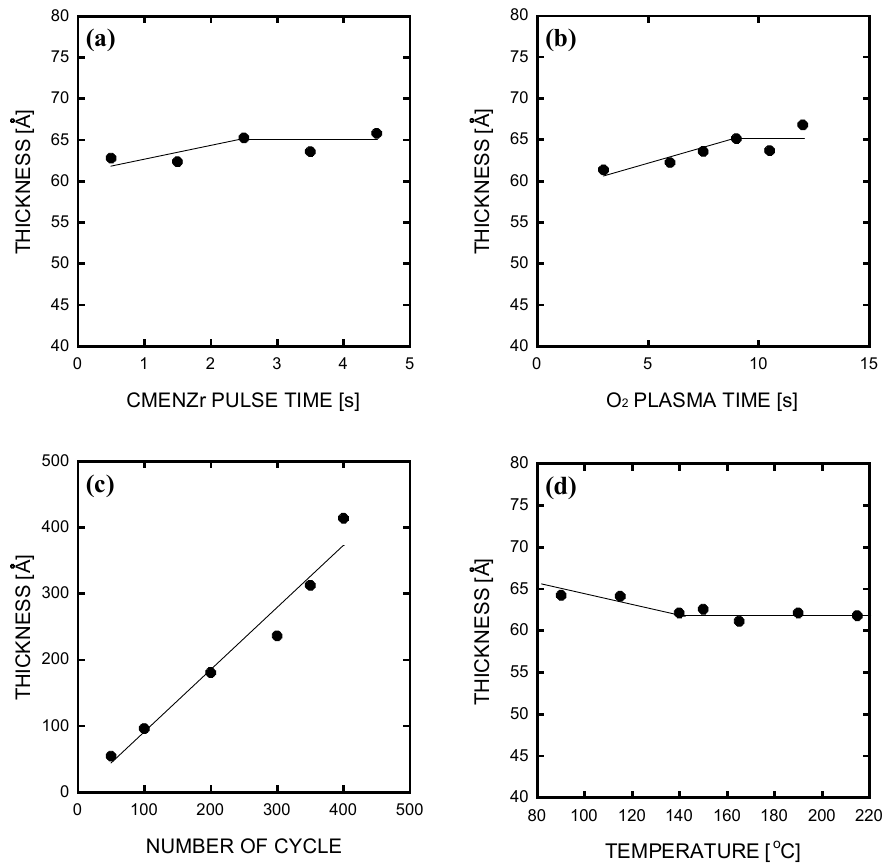
Figure 3. Empirical condition for atomic layer deposition involving CMEN-Zr and oxygen plasma for zirconium and oxygen sources, respectively. ( a ) Deposition temperature: 150 °C, O 2 plasma pulse time: 12 s, ( b ) deposition temperature: 150 °C, CMEN-Zr pulse time: 4.5 s, ( c ) cycle dependence of CMEN-Zr-based ZrO 2 deposition (CMEN-Zr pulse time: 2.5 s, O 2 plasma pulse time: 9 s) and ( d ) temperature dependence of ALD deposition (temperature: 150 °C, O 2 CMEN-Zr pulse time: 2.5 s, plasma pulse time: 9 s).